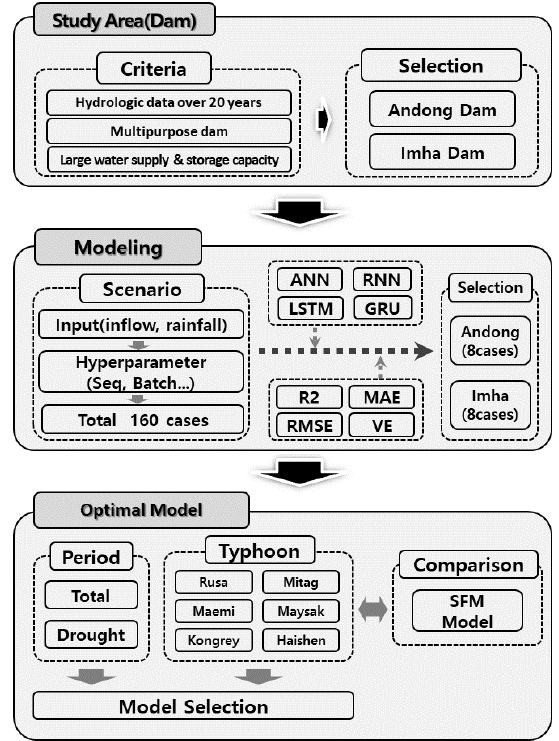
Figure 1. Flow chart of this study.